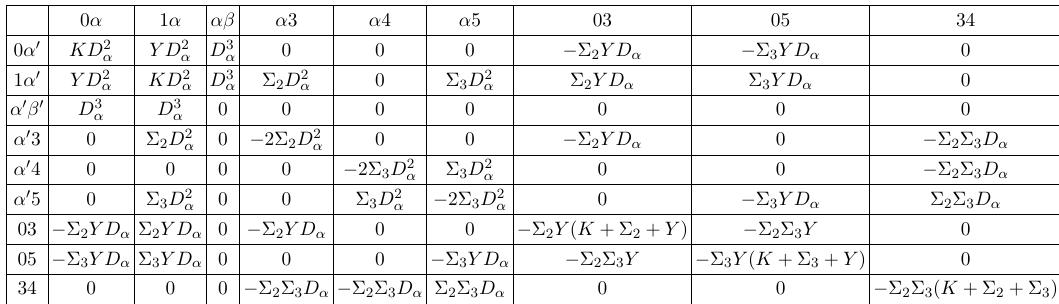
in alternative basis. Compared to the basis used in table 5, Table 6 . Matrix elements M red(IJ)(KL) we find this basis to be more convenient in some approaches for computing the chiral indices — see section